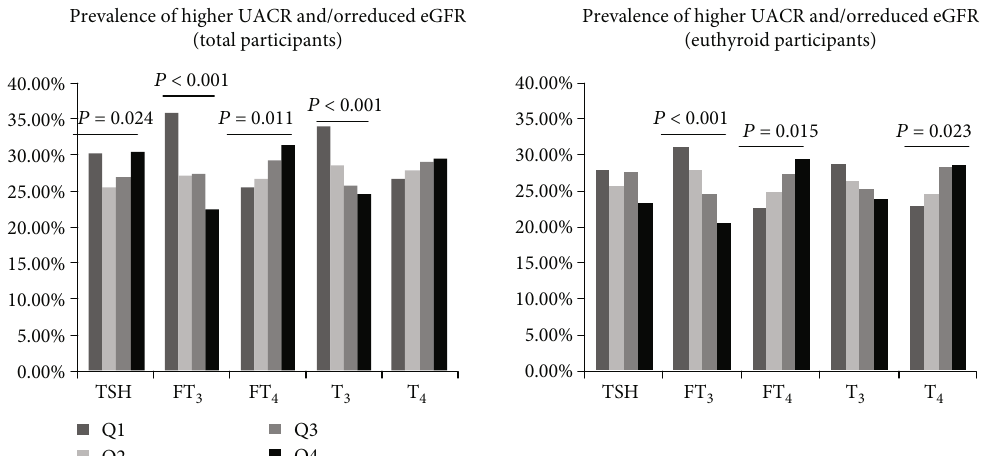
Figure 2: The prevalence of reduced eGFR, higher UACR, and higher UACR and/or reduced eGFR according to thyroid hormone quartile